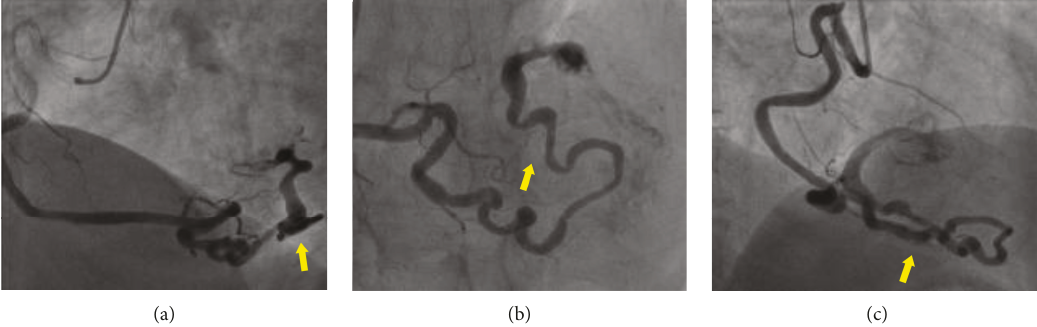
Figure 2: Coronary angiography: right coronary artery stenosis of 50% at the end of the proximal portion. Presence of a tortuous voluminous coronary fi stula